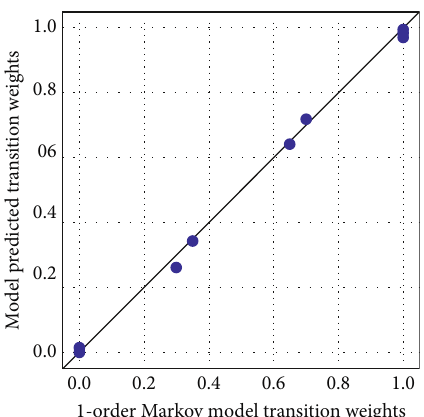
Figure 6: Crossvalidation of the transition probabilities of the first-order Markov